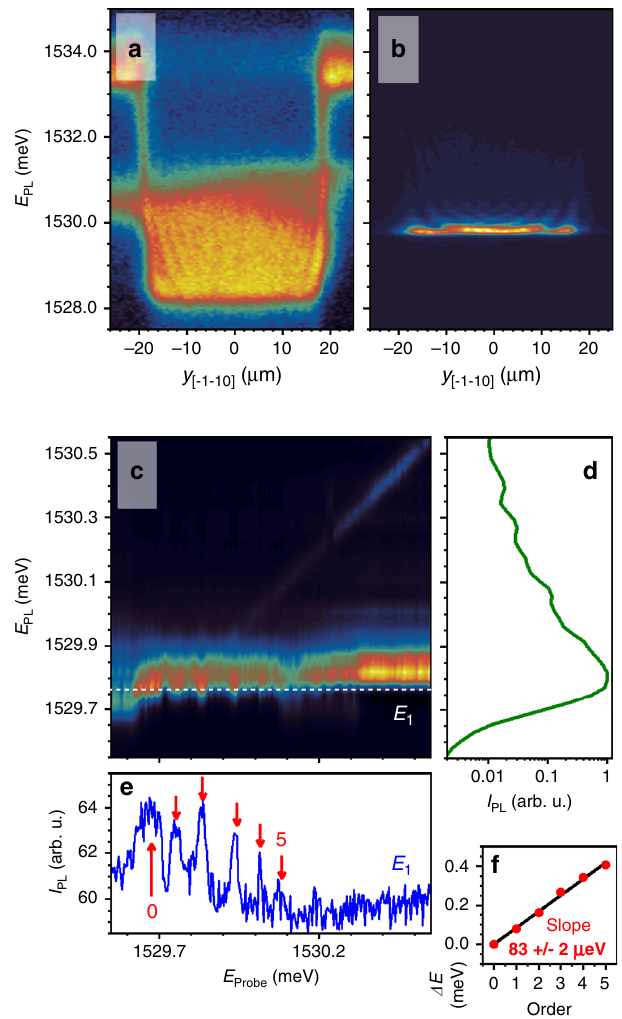
Fig. 1 Bose – Einstein condensate optomechanical induced ampli fi cation. a , b Photoluminescence (PL) color maps of exciton – polaritons con fi ned in a 40- μ m-wide stripe. The two spatial images were recorded for nonresonant excitation powers well below ( a , P Pump = 10 − 4 P Th ) and above ( b , P Pump = 2.3 P Th ) the condensation threshold power P Th . c Color map of the spectral PL dependence on the probe laser energy. d The integrated PL intensity. e The emission amplitude of the fundamental BEC state as a function of the probe laser energy. The arrows highlight the peaks corresponding to the OMIA processes. Their energies as a function of the peak order are displayed in f